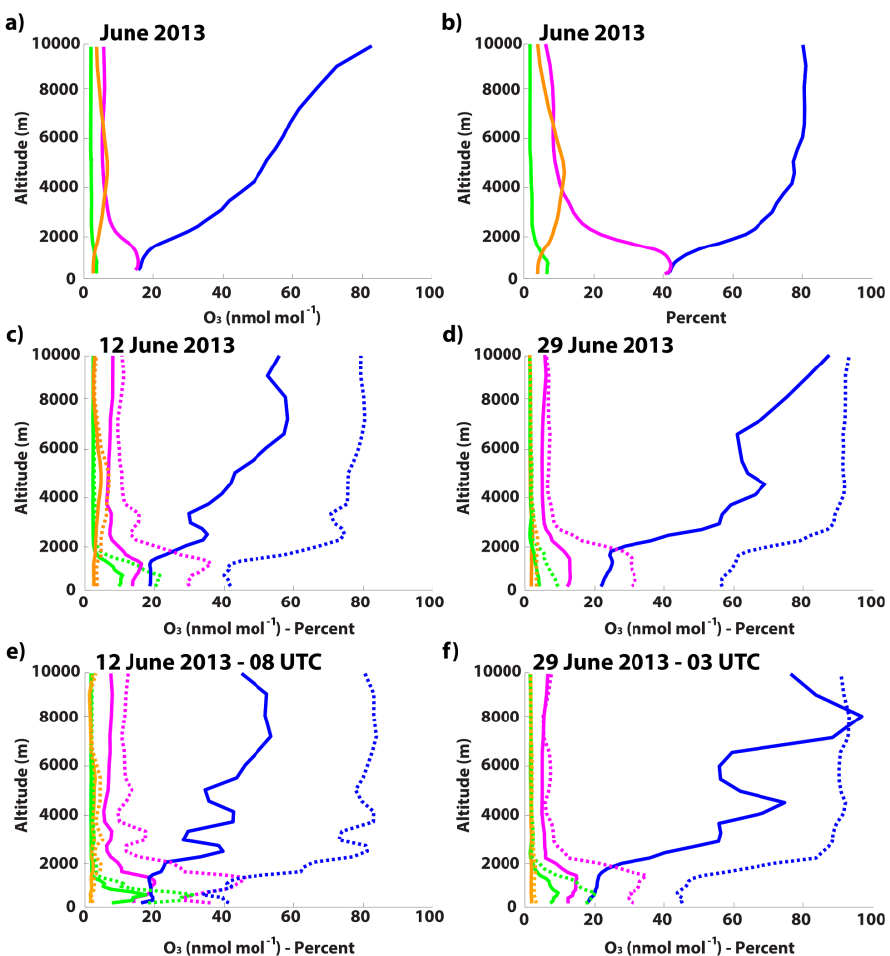
Figure 5. GEOS-Chem-predicted source contribution of O 3 (nmol mol −1 ) from North American anthropogenic emissions (magenta line), wildfires (green line), lightning NO x (orange line), and long-range/stratospheric (blue line) at the UAH TOLNet station. Monthly averaged ( a ) concentrations and ( b ) percent contribution to total O 3 are shown for reference to daily/hourly values; Daily-averaged concentrations (solid lines) and percent contributions (dashed lines) are displayed for ( c ) 12 June 2013 and ( d ) 29 June 2013 along with hourly-averaged concentration and percent contributions at ( e ) 08 UTC on 12 June 2013 and ( f ) 03 UTC on 29 June 2013.